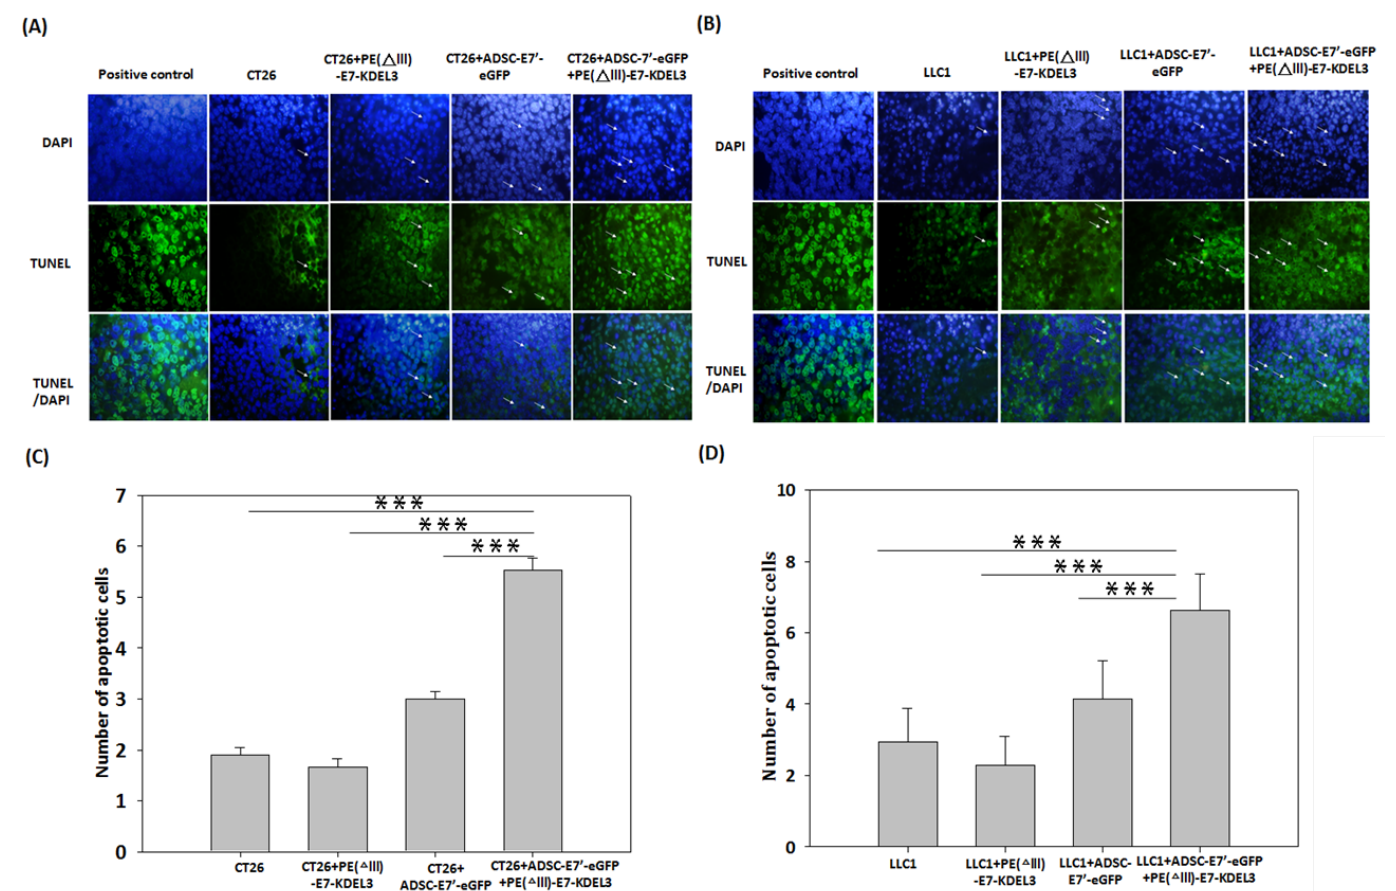
Figure 4. Evaluation of apoptosis in tumor tissues by TUNEL staining. Representative fluorescence images of ( A ) the CT26 tumor with different treatments; or ( B ) the LLC1 tumor with different treatments. Apoptotic-positive cells were shown in green (arrows) and the cellular nucleus was stained by DAPI and shown in blue. ( C , D ) The number of apoptotic-positive cells in the microscopic fields were calculated. The quantitative results are presented as means + standard error of means (SEM); *** indicates p < 0.001 using unpaired t -test with Welch's correction. Magnification A,B: 50µm.